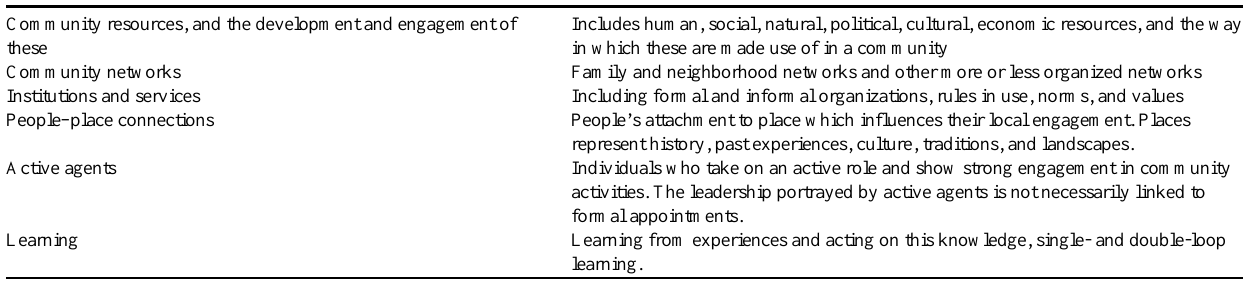
Table 2 . Dimensions of community resilience. Community resources, and the development and engagement of